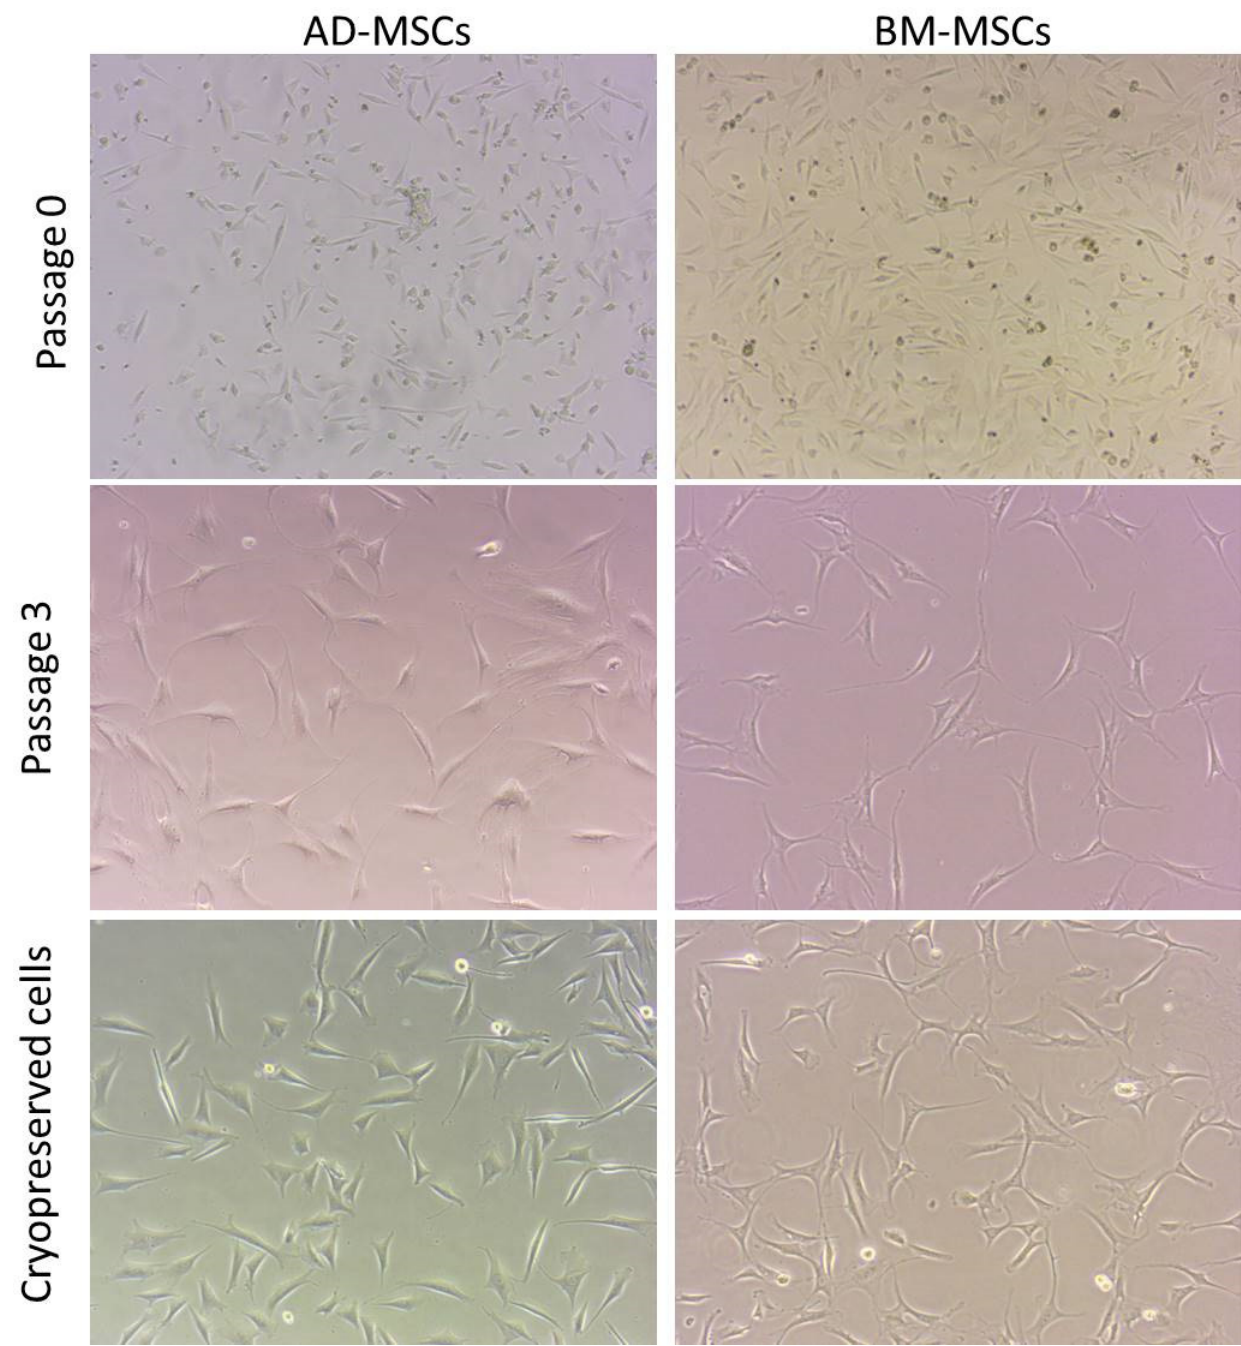
Figure 2. Plastic adherent mesenchymal stem cells (MSCs) of adipose tissue and bone marrow-derived tissues. The cells at passage 0 had varied morphology while cells at later passage (P3) had typical fibroblast morphology. P0: cells at passage 0; P3: cells at passage 3; Cryopreservation: cell confluency (P4) after cryopreservation (Magnification: 20×).